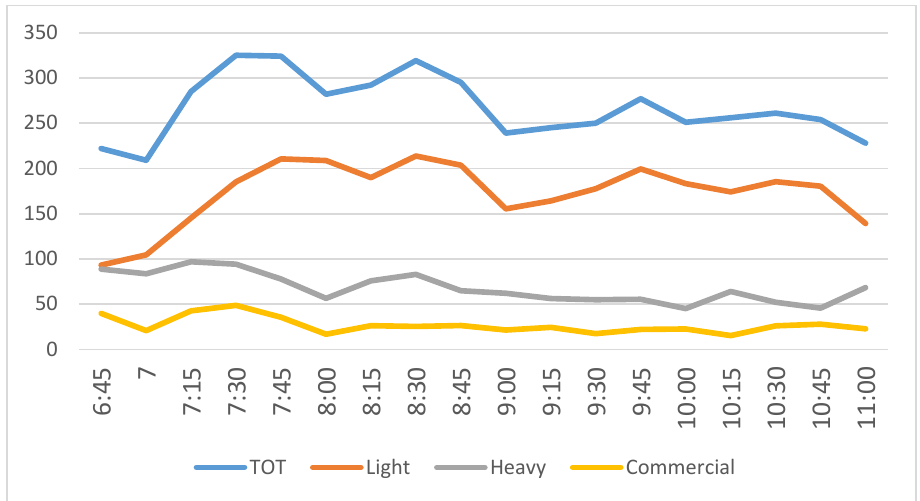
Figure 6. Vehicle input and traffic composition (No. of vehicles) .